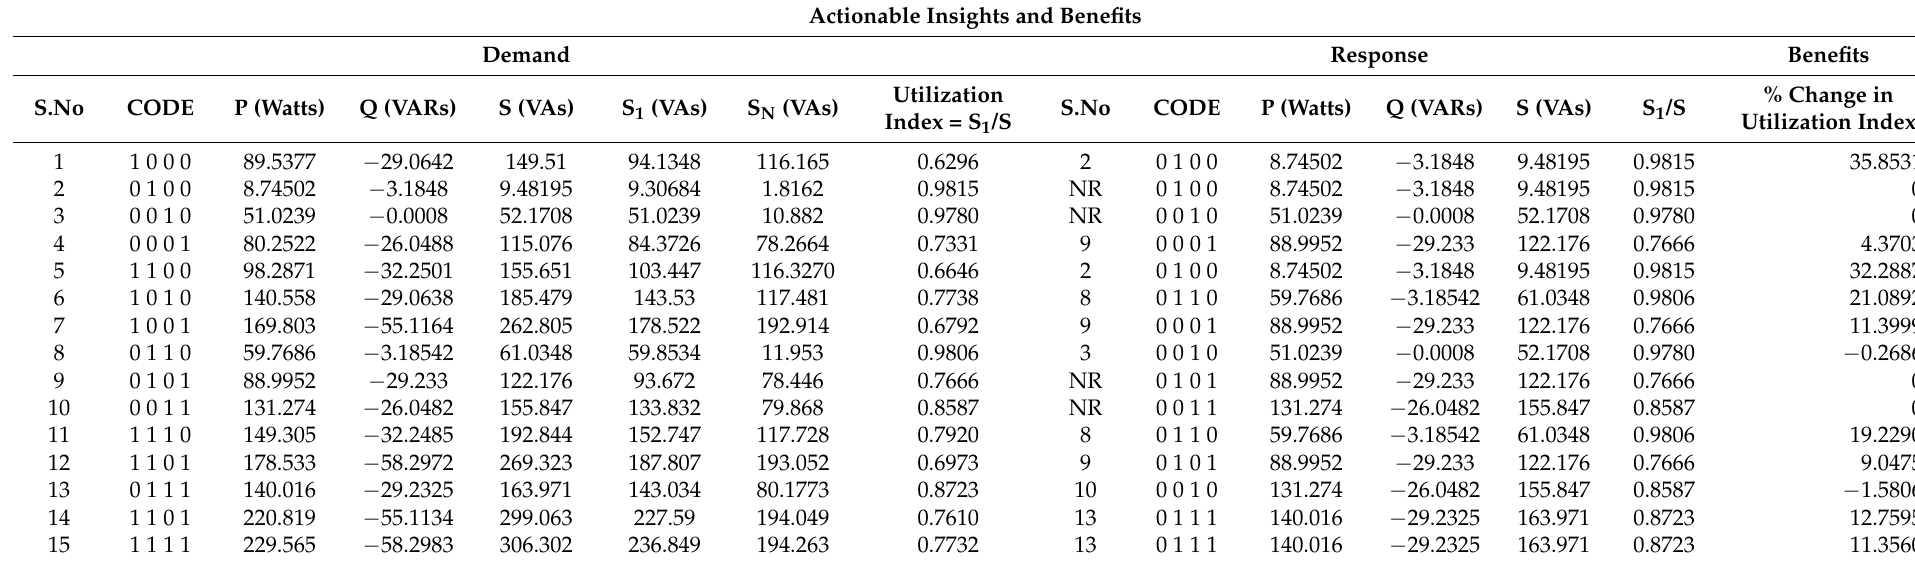
Table 4. Actionable insights for the improvement of the utilization